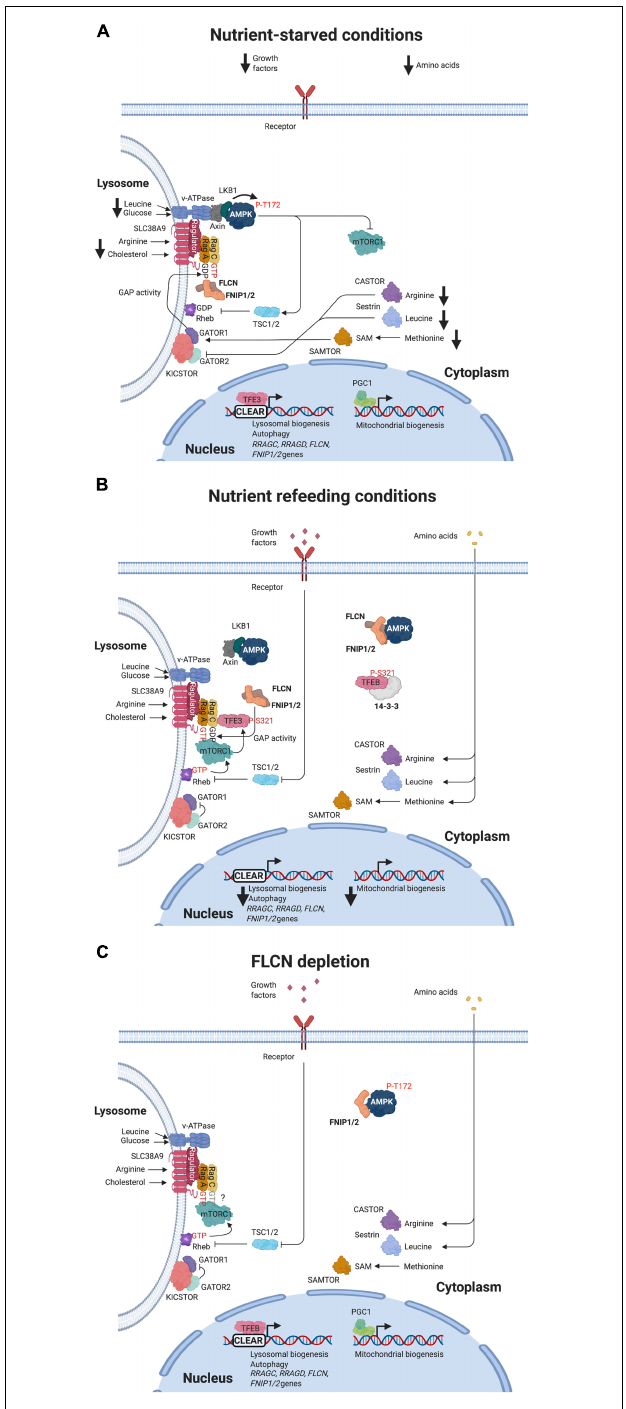
FIGURE 2 | Regulation of mTORC1 and AMPK signaling pathways in response to nutrient availability or FLCN depletion. (A) Under nutrient starvation, amino acid sensors facilitate activation of GATOR1 complex, which promotes GTP hydrolysis by Rag A/B. Inactivation of Rag A/B impairs the recruitment of mTORC1 but facilitates the binding of FLCN/FNIP complex to the Rags. Low glucose levels trigger the assembly of AXIN, LKB1, and AMPK with v-ATPase forming a complex that induces LKB1-mediated